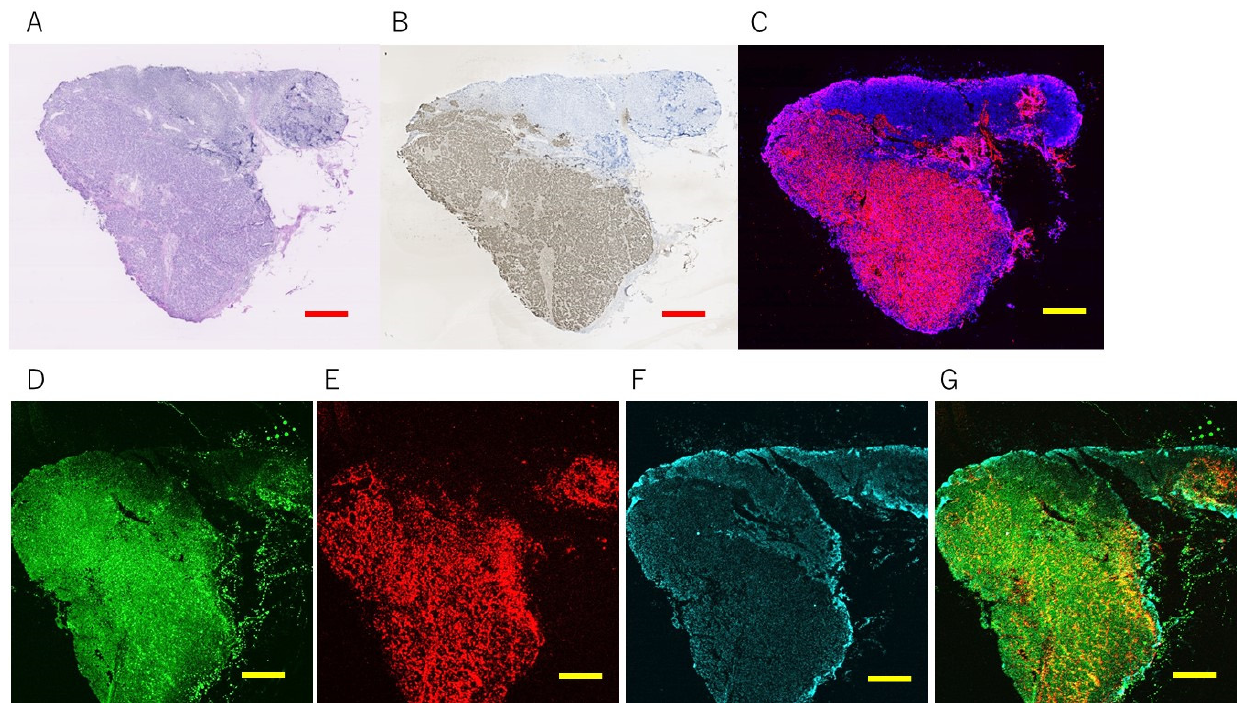
Figure 8. Staining of a frozen tissue section of a human breast cancer metastatic lymph node. ( A ): Hematoxylin and eosin (HE) staining. ( B ): Conventional immunostaining (diaminobenzidine). ( C ): Single staining of magnetically promoted rapid immunofluorescence (MRIF) with anti-pan-cytokeratin antibody-coated FF beads that emitted magenta fluorescence. Multi-colored MRIF using anti-CK19 antibody-coated F beads that emitted green fluorescence ( D ), anti-TNC antibody-coated FF beads that emitted red fluorescence ( E ), DAPI staining ( F ), and merged images ( G ). Scale bar = 1000 µm Adapted from Onishi et al. and new data.